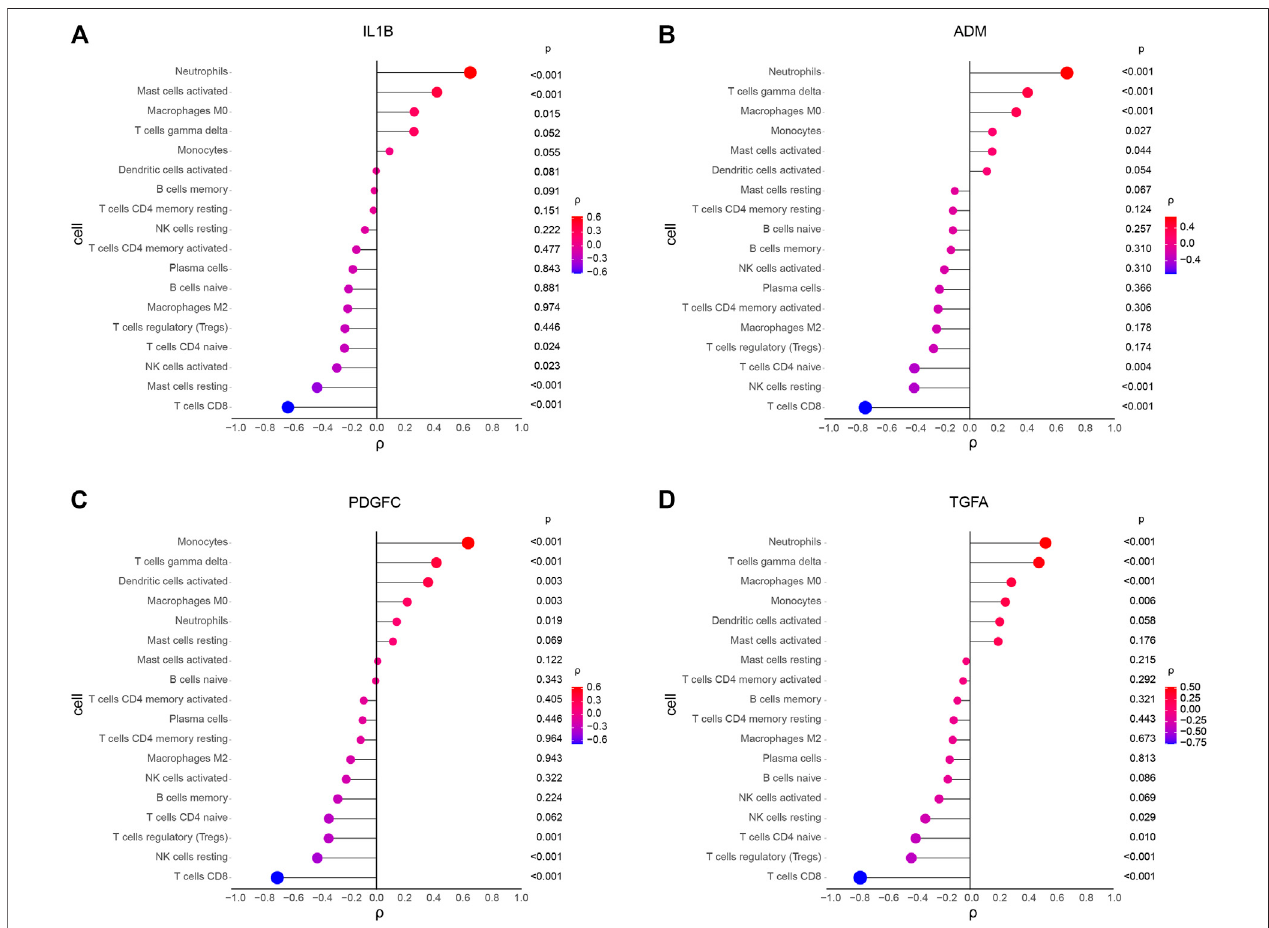
FIGURE 7 | Spearman correlation analysis between diagnostic markers and immune cells in KD. (A) Correlation between IL1B and immune cells. (B) Correlation between ADM and immune cells. (C) Correlation between PDGFC and immune cells. (D) Correlation between TGFA and immune cells. The size and color of the dots representsthe p -valueandthestrengthofthecorrelationbetweendiagnosticmarkersandimmunecells;redrepresentsthepositivecorrelation,andbluerepresentsthe negativecorrelation.Thelargerthedots,thelowerthe p -value,andthebluerorredder,thestrongerthecorrelation. p < 0.05wasconsideredstatisticallysigni fi cant.